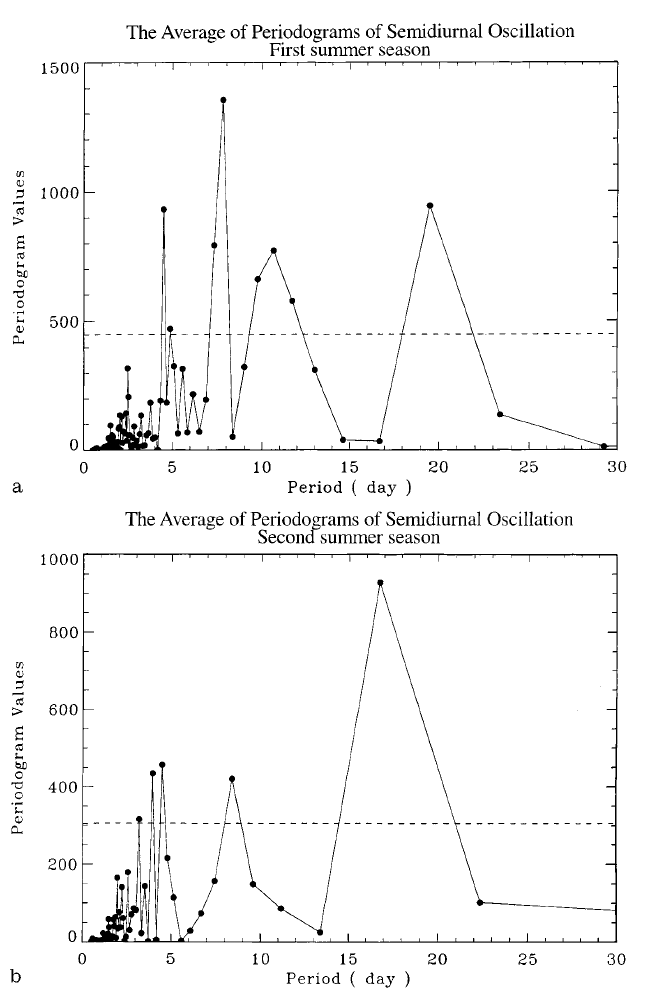
Fig. 6. a Spectrum of the time-series of Fig. 5. b As in part a , except corresponding to November 1996–January 1997